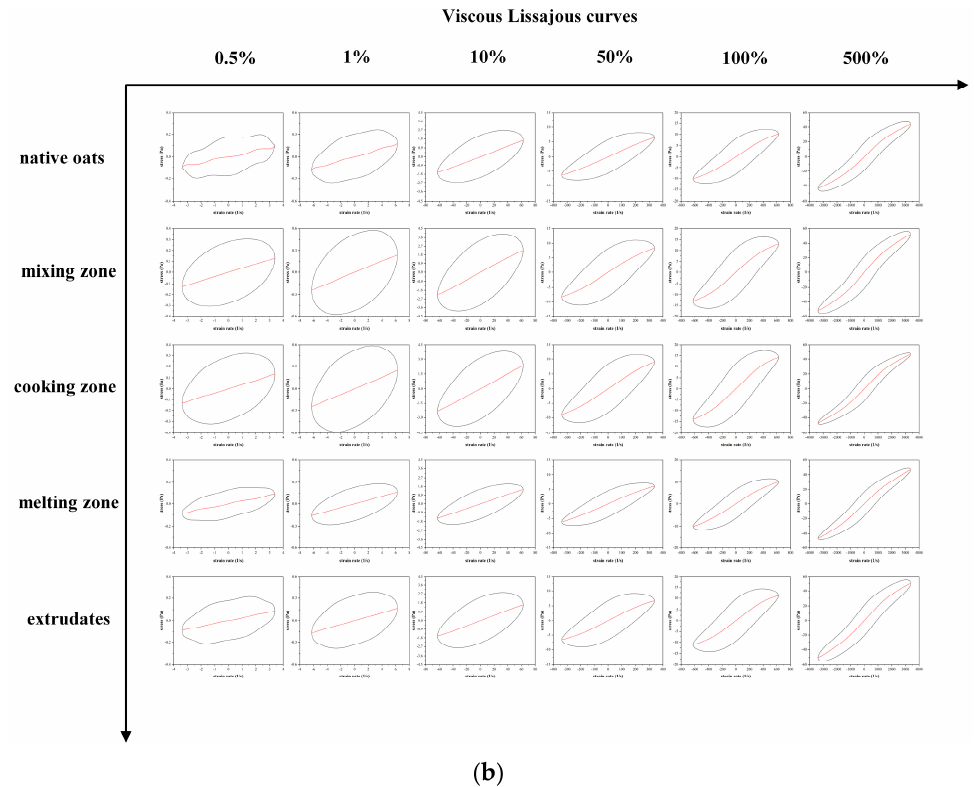
Figure 6. Elastic Lissajous curves ( a ) and viscous Lissajous curves ( b ) of oat paste for native oat (raw), in mixing zone (I), cooking zone (II), melting zone (III), and extrudates (IV) and strain amplitude of 0.5%, 1%, 10%, 50%, 100%, and 500%, respectively.